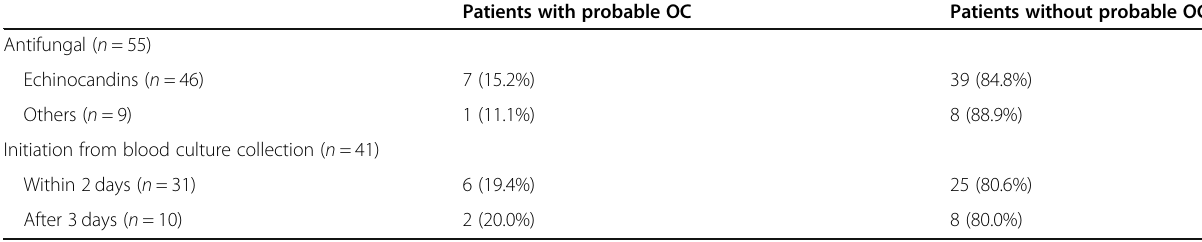
Table 3 Relationship between initial antifungal therapy and the development of probable OC Patients with probable